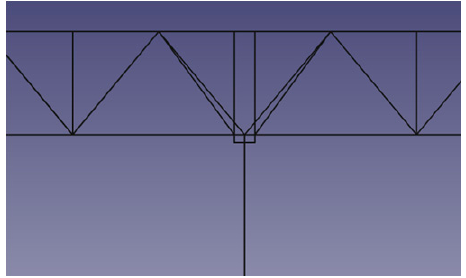
Figure 13. Connections with the supports and steel truss at the block interfaces.